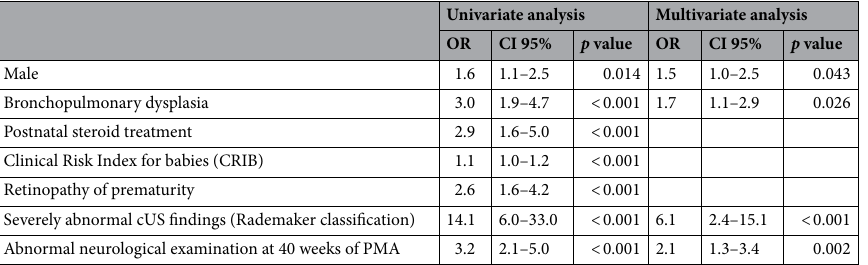
Table 3. Univariate and multivariate analysis of risk factors for adverse neurodevelopmental outcome. cUS cranial ultrasonography, PMA postmenstrual age, OR odd